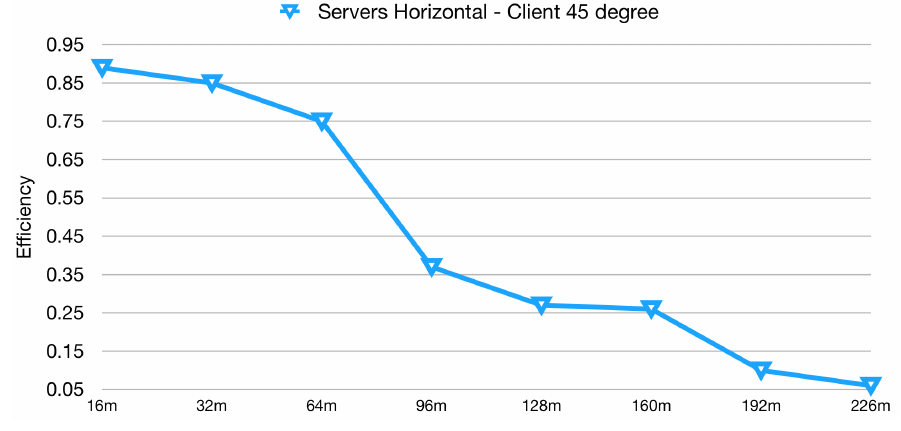
Figure 6. Bluetooth® data reception rate in long-range